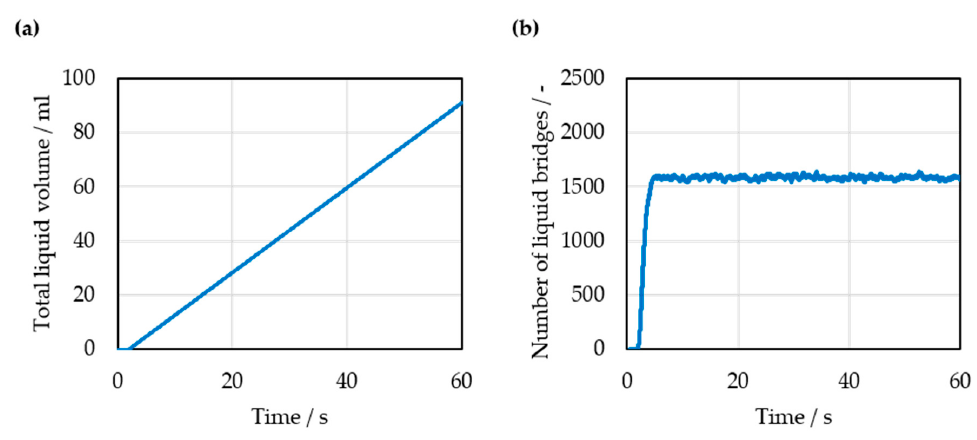
Figure 6. Average contact force acting on the particle ( a ) and average particle velocity ( b ) for the dry and wet case.